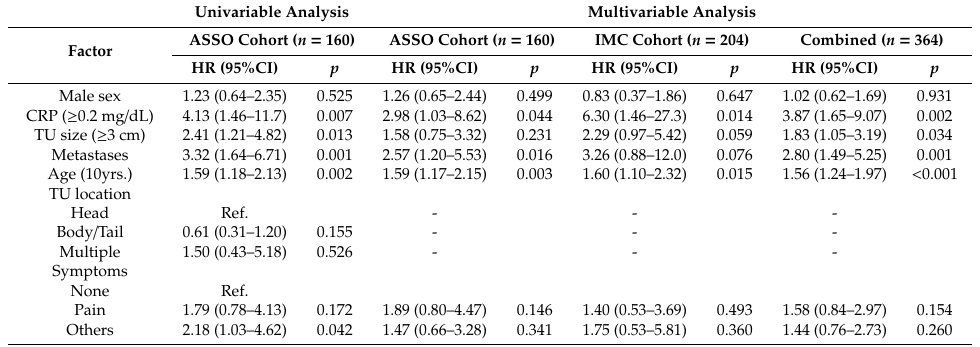
Table 2. Univariable and multivariable analysis of preoperative factors associated with overall